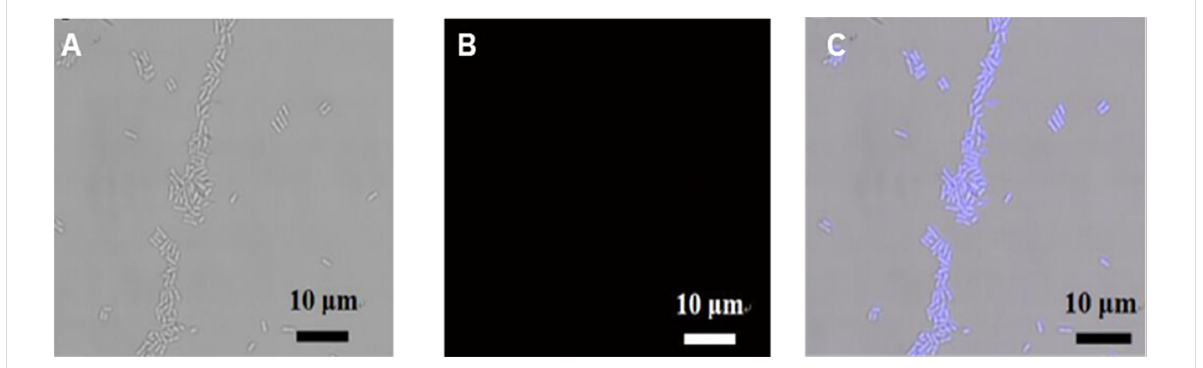
Figure 7: Confocal images of Xag . (A) Bright field without S b , (B) fluorescence mode without S b and (C) merged channel image with 5.0 μ g mL − 1 of S b incubated for 3 h at 37 °C.